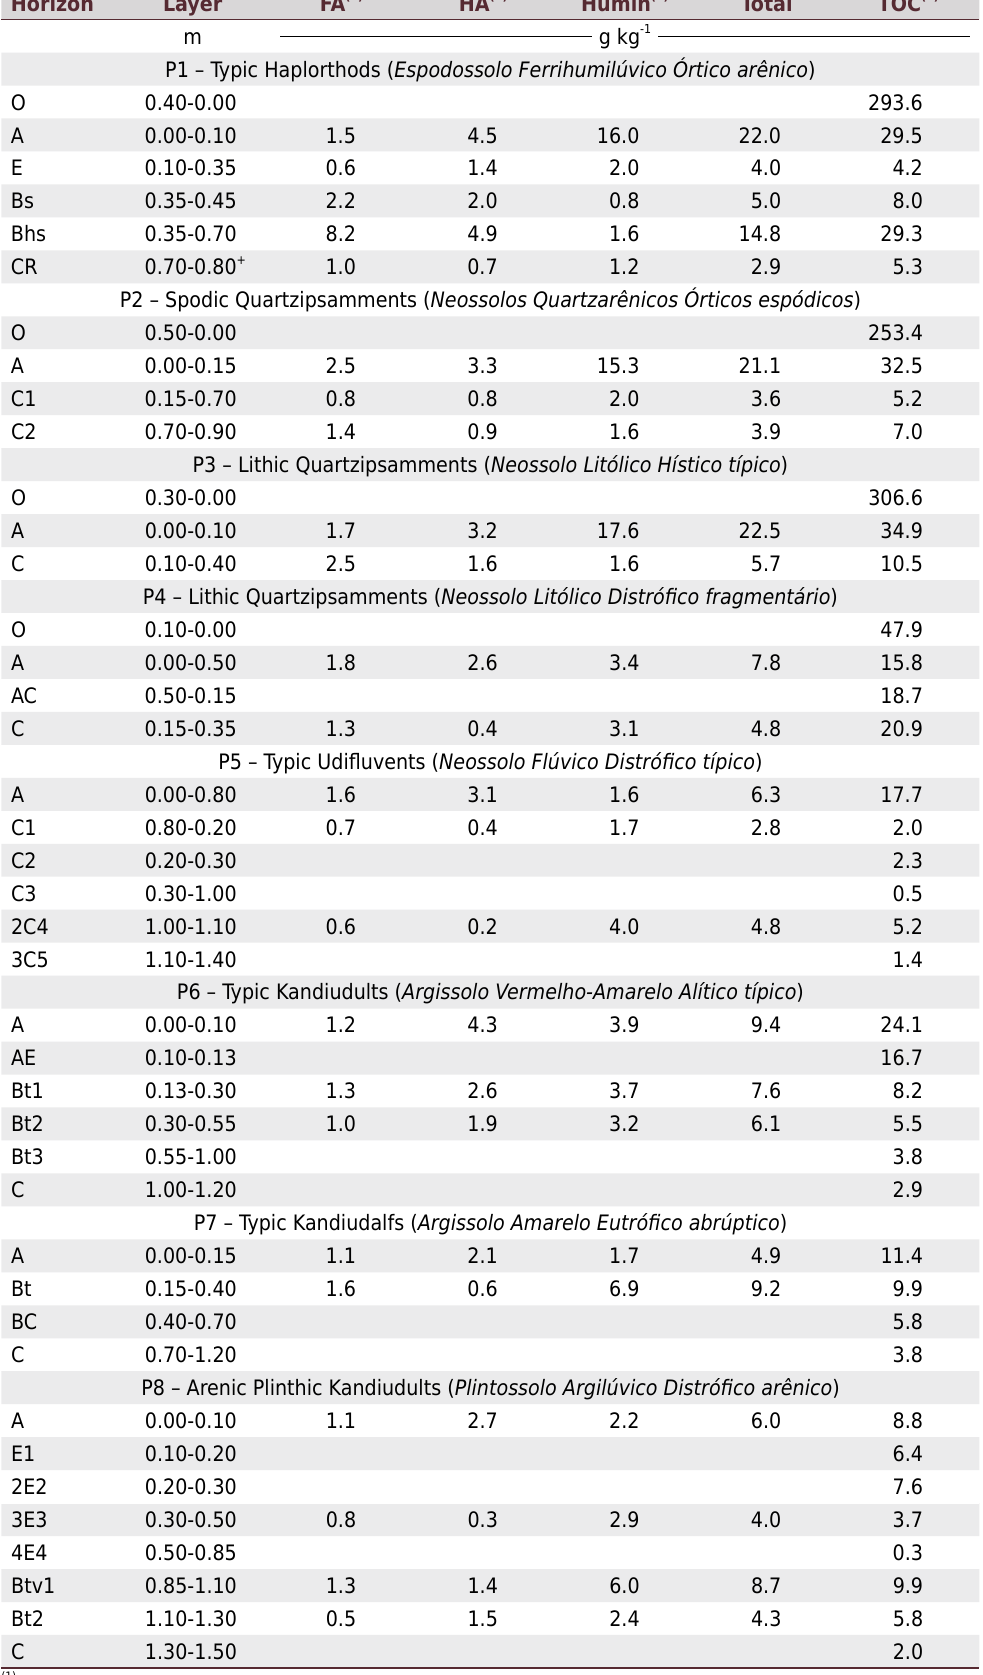
Table 6. Organic matter fraction and total organic carbon (TOC) of the studied soils Horizon